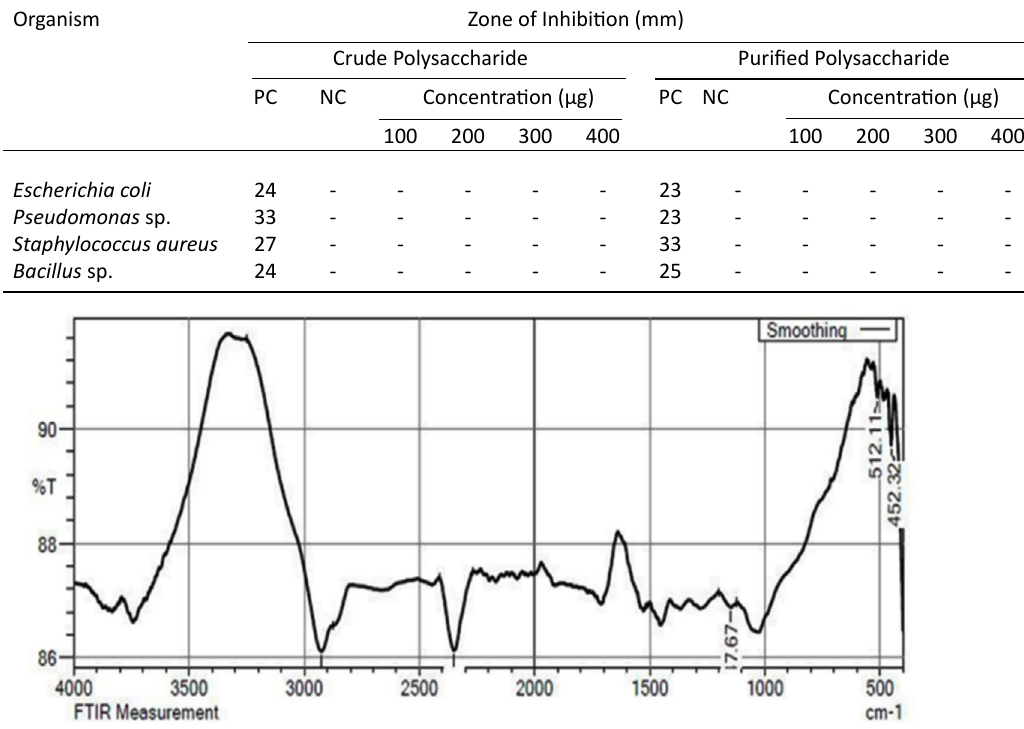
Table 1. Antibacterial activity of polysaccharide Organism Zone of Inhibition (mm) Crude Polysaccharide Purified Polysaccharide PC NC Concentration (µg) PC NC Concentration (µg) 100